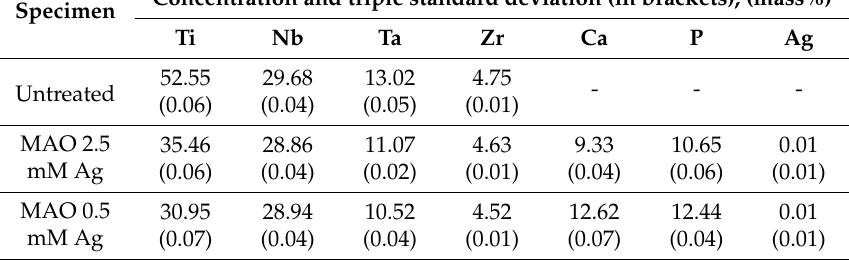
Figure 2. XRF spectra of ( a ) untreated, ( b ) MAO-treated with 2.5 mM Ag, and ( c ) MAO-treated with 0.5 mM Ag around the Ag K α energy region. Table 2. Concentrations of the detected elements by XRF on TNTZ specimen surfaces with/without MAO